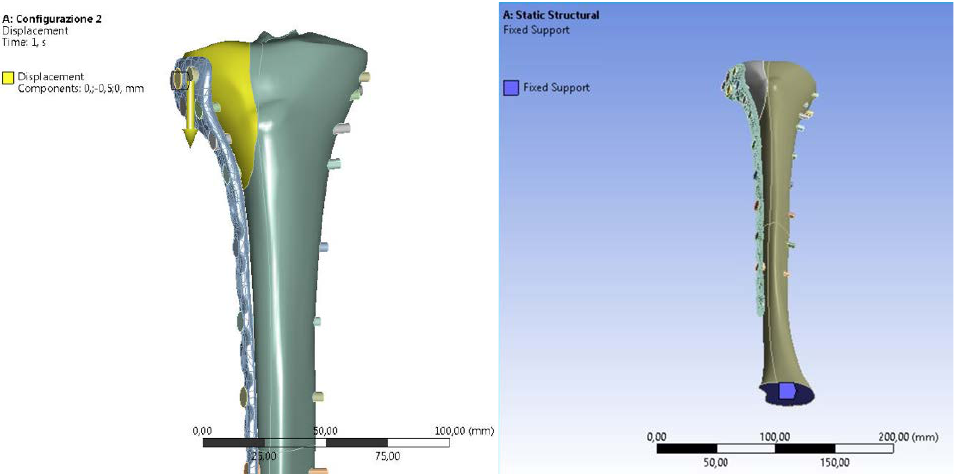
Figure 8. Boundary conditions: imposed displacement (left) and fully constrained surface (right).